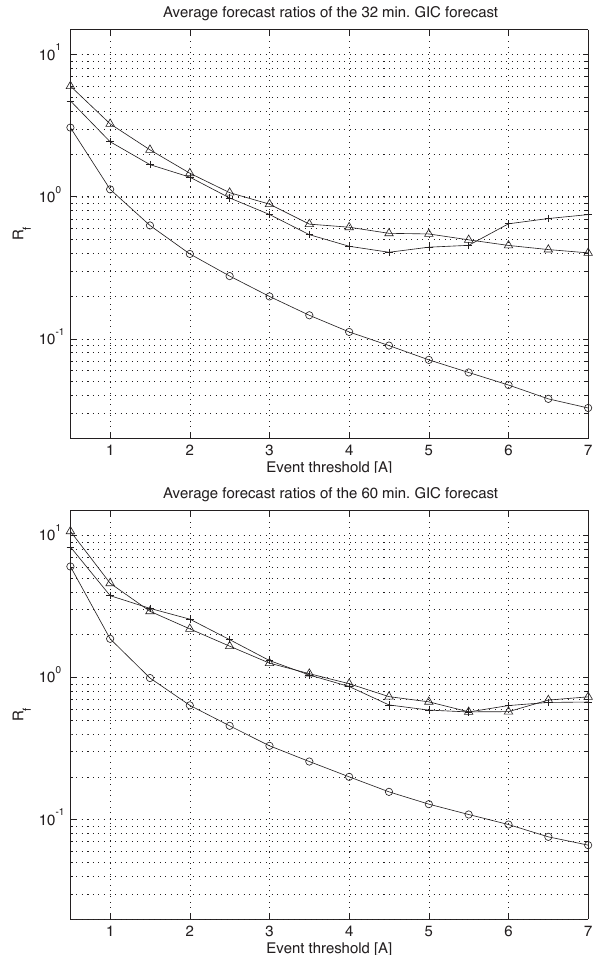
Fig. 9. Forecast ratios N H /N of the modeled GIC (plusses) and H persistence models 1 (circles) and 2 (triangles) as a function of the event threshold | GIC thres | . Top panel: forecast window t f of 32min was used. Bottom panel: forecast window t f of 60min was